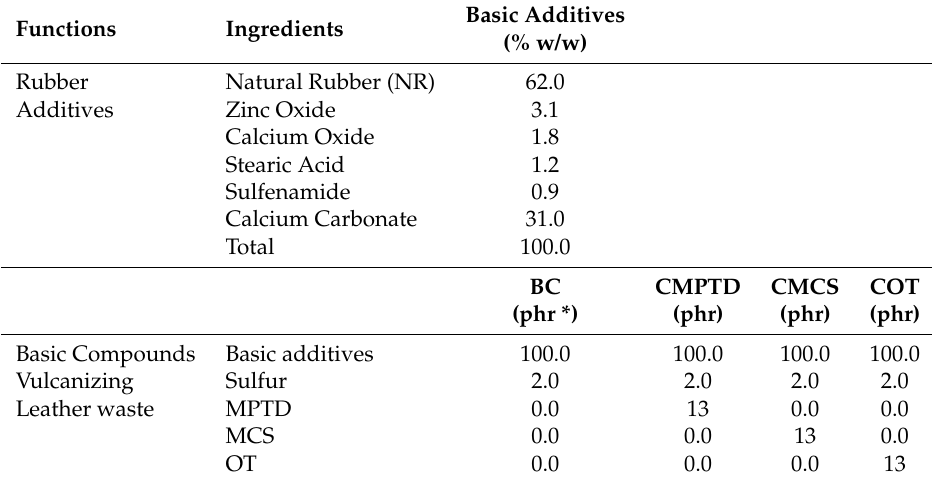
Table 1. Chemical composition of standard reference and rubber compounds formulation prepared from leather